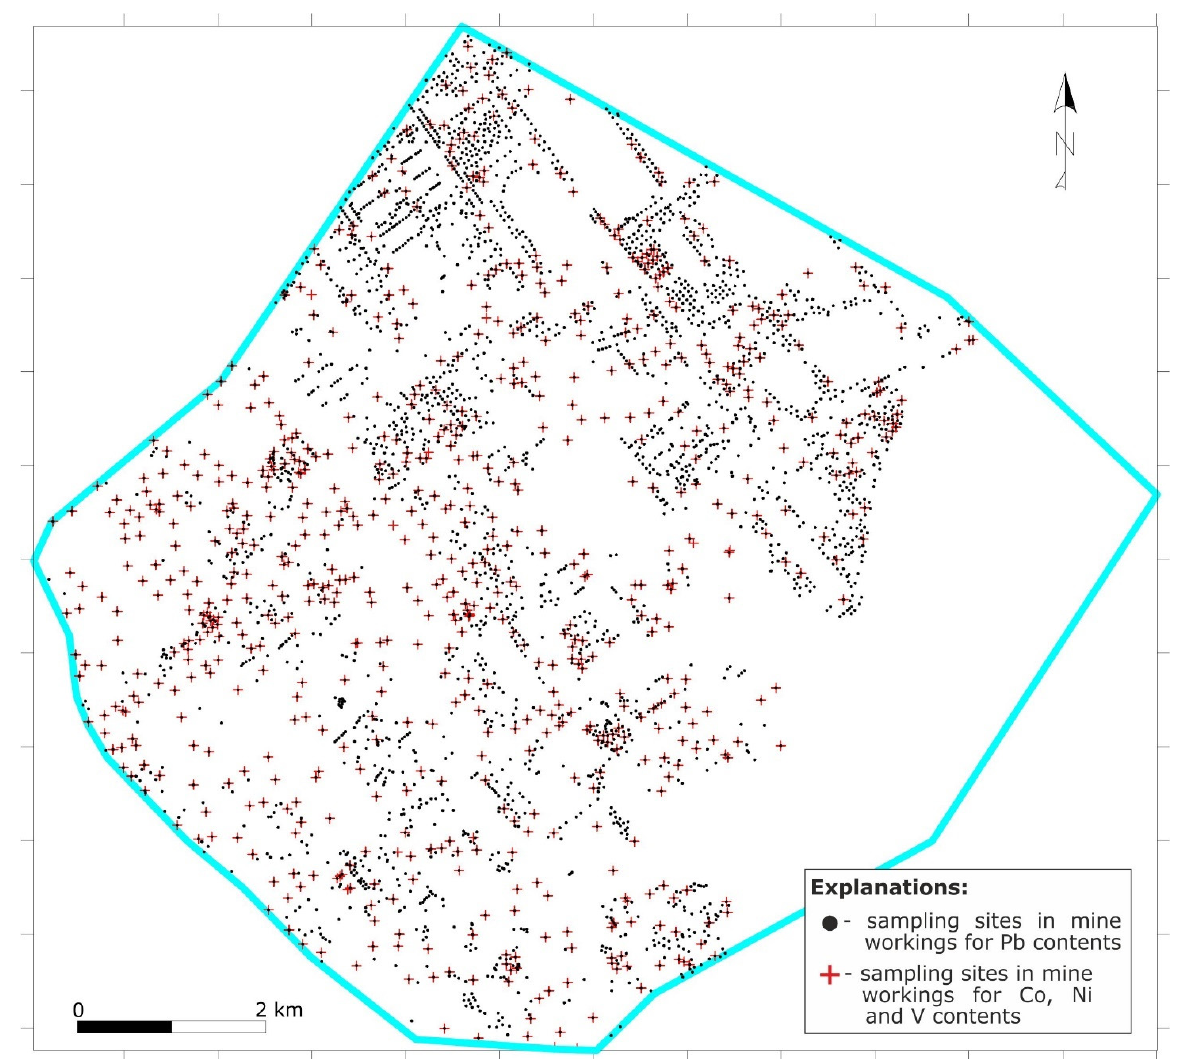
Figure 4. Location of sampling sites in mining excavations for the determination of cobalt, nickel, lead, and vanadium (Rudna deposit).